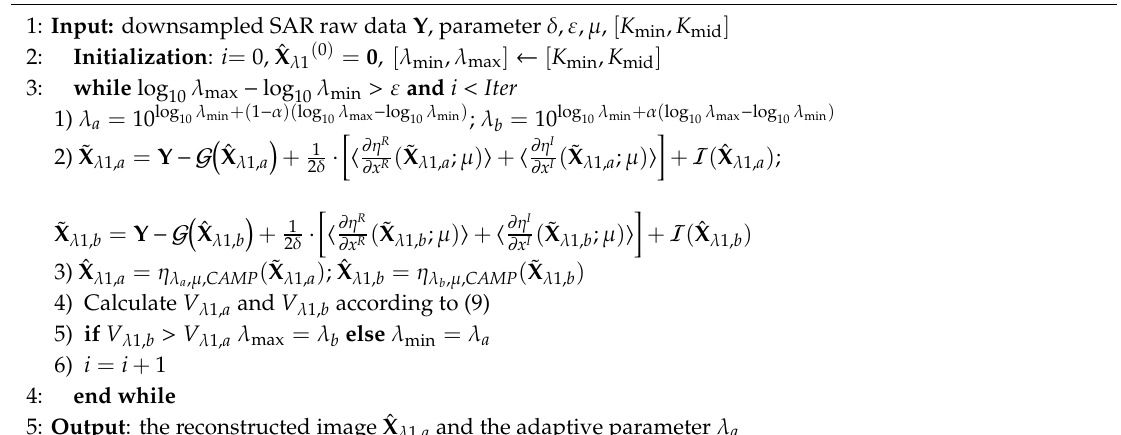
Algorithm 1: The adaptive parameter estimation method based on azimuth-range